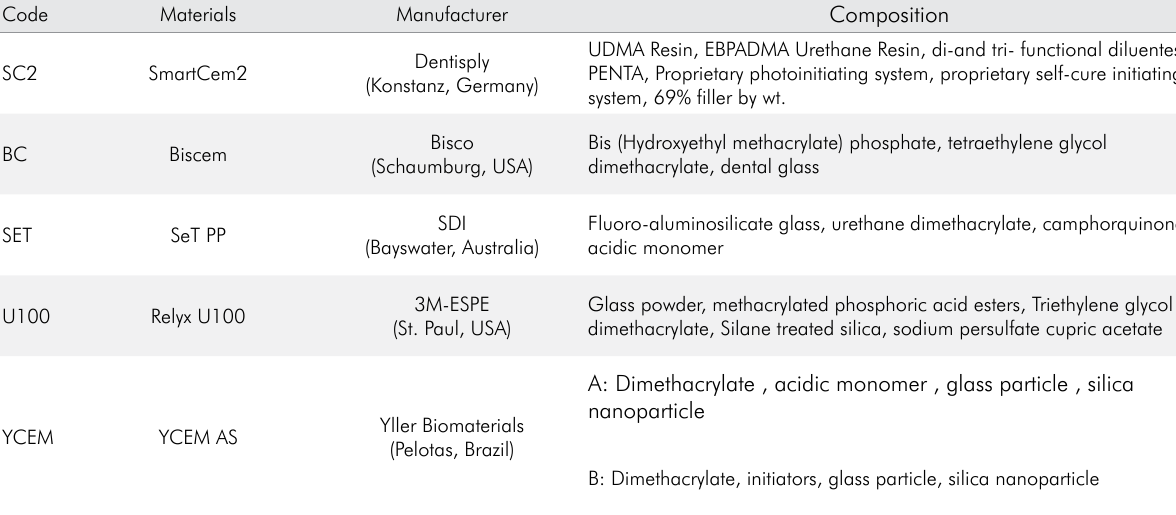
Table 1. Materials tested in this study (manufacturer